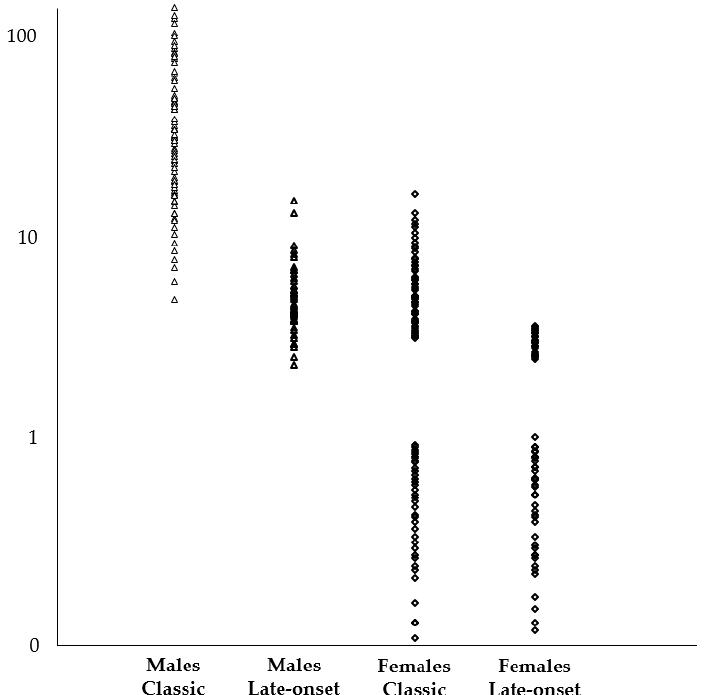
Figure 4. LysoGb3 concentration in blood of patients. LysoGb3 is measured in nmol/L; normal values 0.08–1.13 nmol/L. Logarithmic